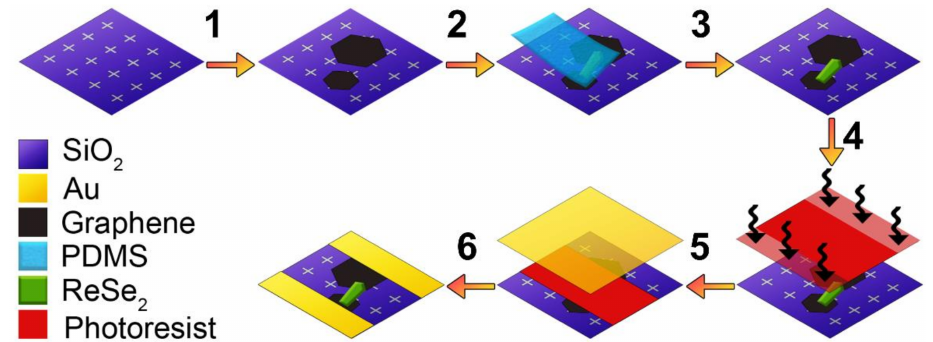
Figure 1. Schematic of the GSC/ReSe 2 device production process: (1) transfer of GSC to a Si/SiO 2 substrate with crosshair markers, (2–3) placement of the exfoliated ReSe2 crystal across two discrete GSCs by “pick & place” method, using a PDMS stamp, (4) spin-coating of photoresist and exposure with laser lithography to form the mask for the metallic contacts, (5) Cr/Au layers sputtering, and (6) partial removal of the metallic layer (lift-off) to form the Cr/Au